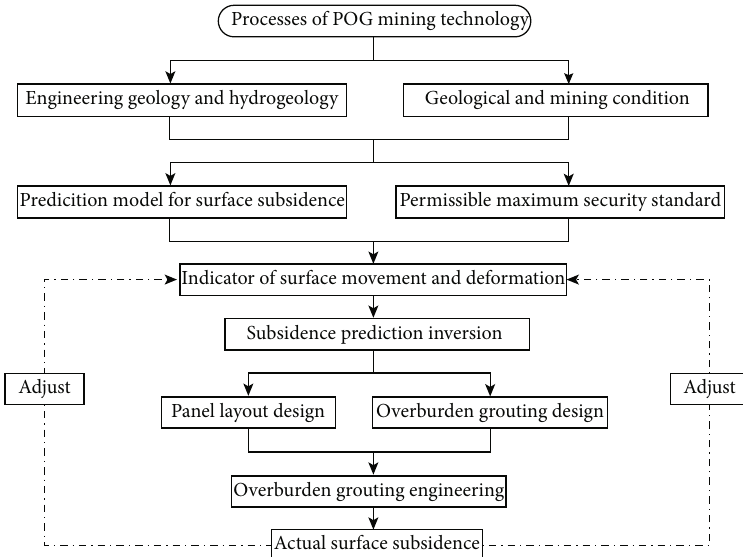
Figure 4: Design process of partial overburden grouting (POG).